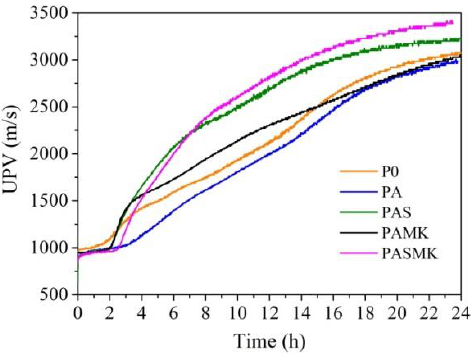
Figure 7. The variation of UPV in fresh mortar mixes P0 – PASMK samples during 24h. After 4 h of hydration, the UPV values for P0 samples reached 1445 m/s, but in the PA sample reached just 1060 m/s, which is 36.0% less than in the control P0 sample. After 24 h of hydration, the UPV values for P0 and PA samples reached 3090 m/s and 2975 m/s